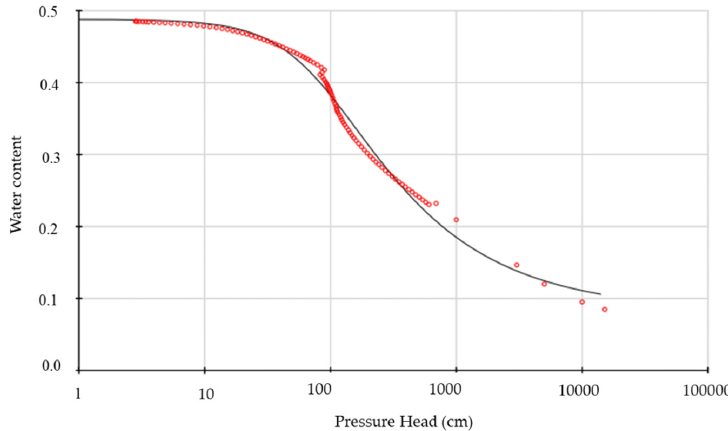
Figure 2. Soil water retention curve (SWRC) of silty sand soil.